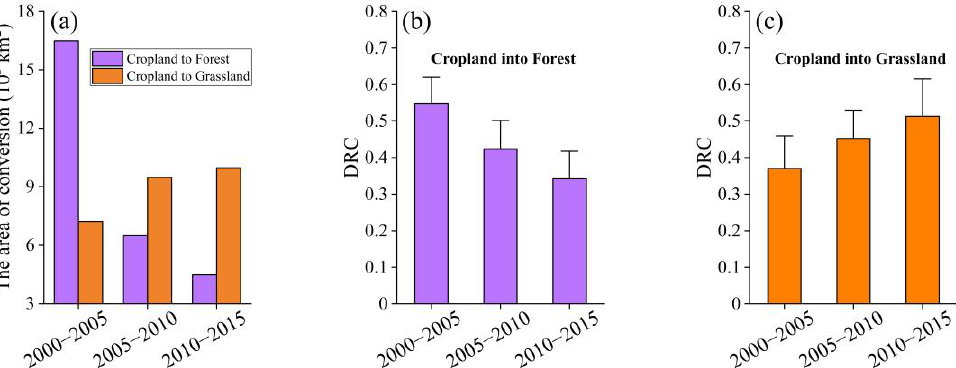
Figure 7. Change of the area ( a ) and DRC (Drought Resistance Coefficient) on the land cover from crops to forest ( b ) and grassland ( c ).